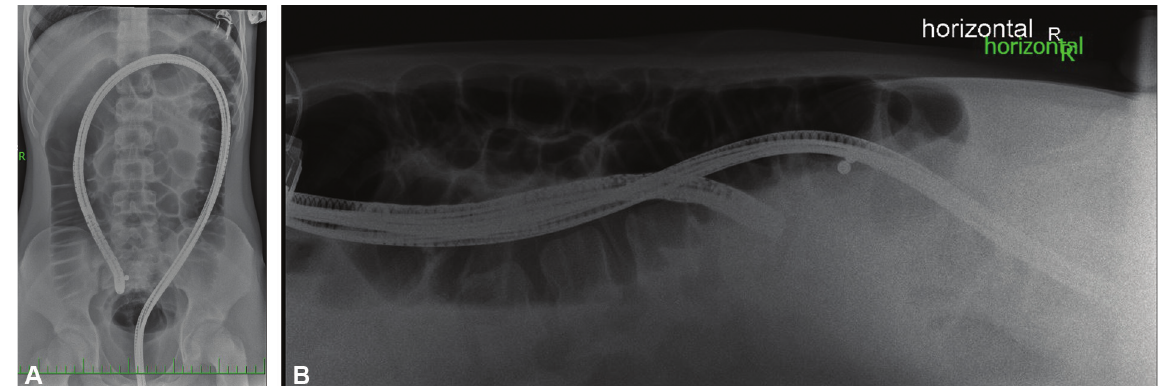
Fig. 3 ( A, B ) Colonoscopy under skiascopic control with visible MFBs. MFBs, magnetic foreign bodies.